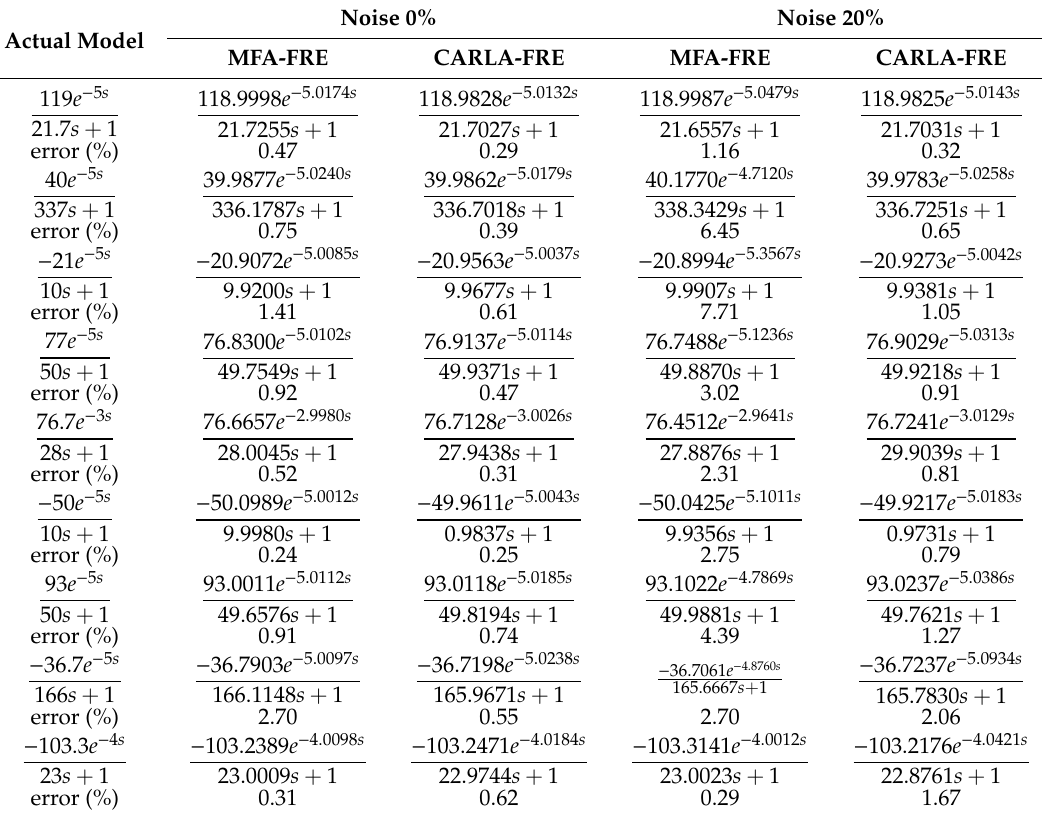
Table 4. Identification results of the Shell